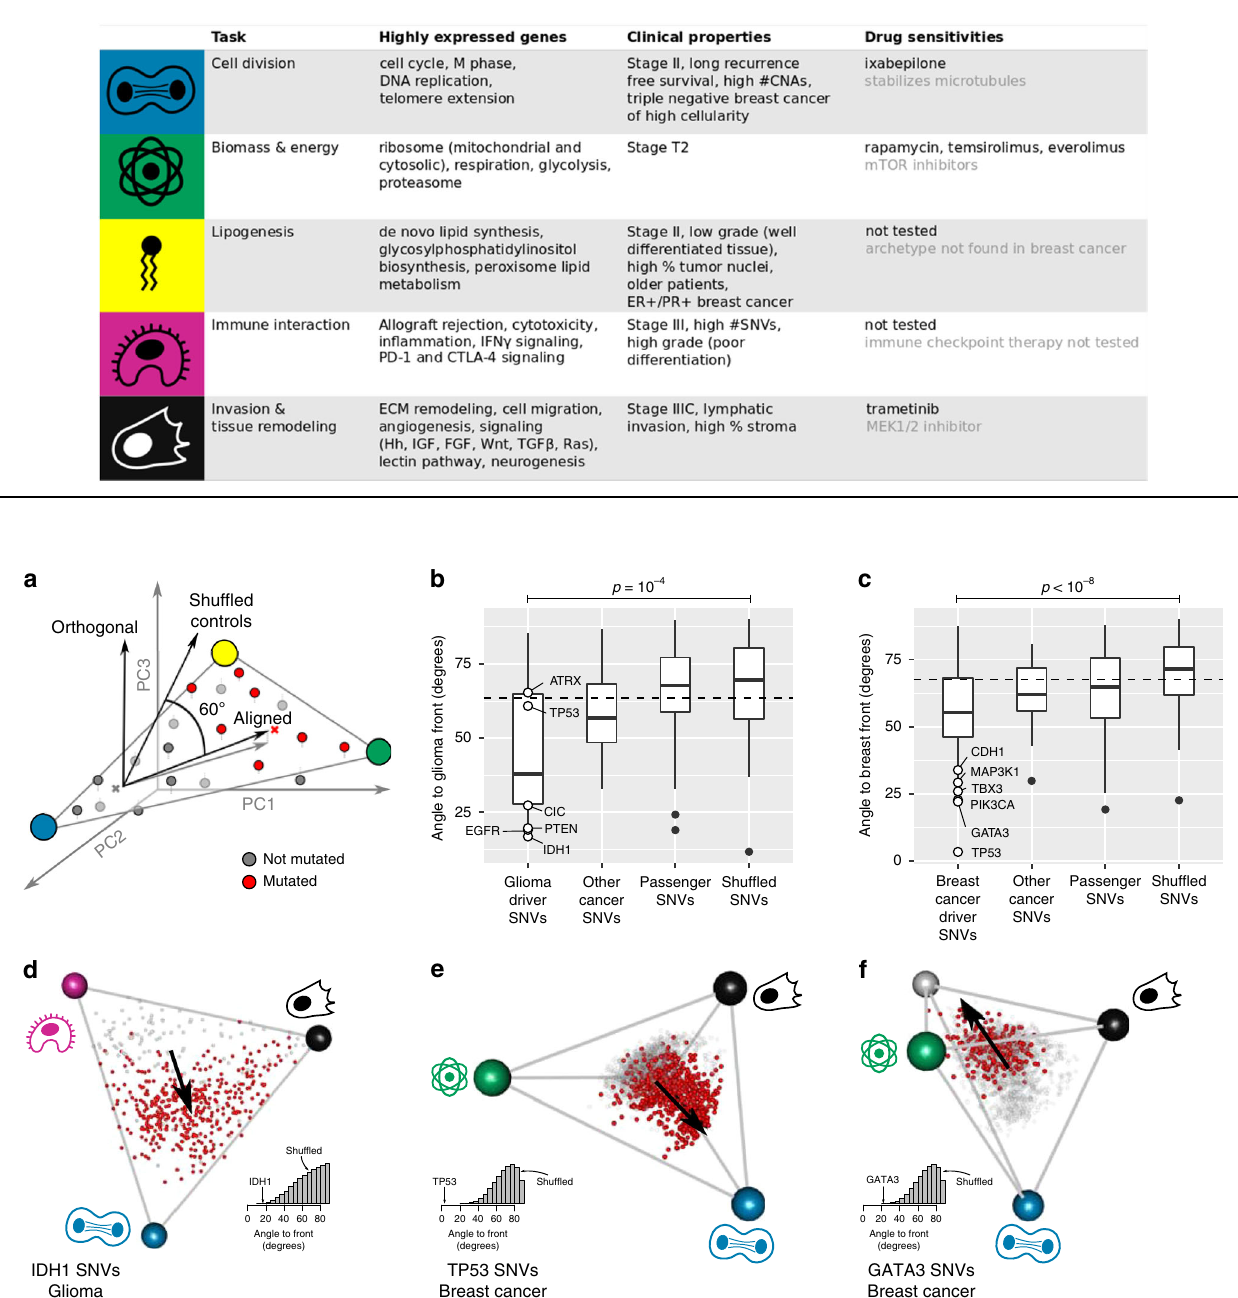
Fig. 3 Driver mutations push tumor expression towards specialization in speci fi c tasks. a The effect of a mutation on gene expression is de fi ned as the vector (grey arrow) connecting the centroids of tumors without (gray) and with (red) the mutation (schematic). Alignment of mutation effect vector to the front is de fi ned by the angle of the effect vector to the subspace de fi ned by the front. Shuf fl ed controls show a 62 – 75° angle with the front depending on cancer type. b – c In glioma ( b ) and breast cancer ( c ), driver mutations are better aligned to the polyhedron formed by the archetypes than passenger mutations and random mutations. White dots: six most frequent driver SNVs in that cancer type. Center line, median; box limits, upper and lower quartiles; whiskers, 1.5× interquartile range; black dots, outliers. P -values from the Mann – Whitney test ( n = 18 driver mutations for glioma, n = 53 for breast). d In low-grade glioma, IDH1 SNVs point approximately towards the cell division archetype. e In breast cancer, TP53 SNVs point towards the cell division archetype. f In breast cancer, GATA3 SNVs point towards the face de fi ned by the lipogenesis, invasion and tissue remodeling and HER2